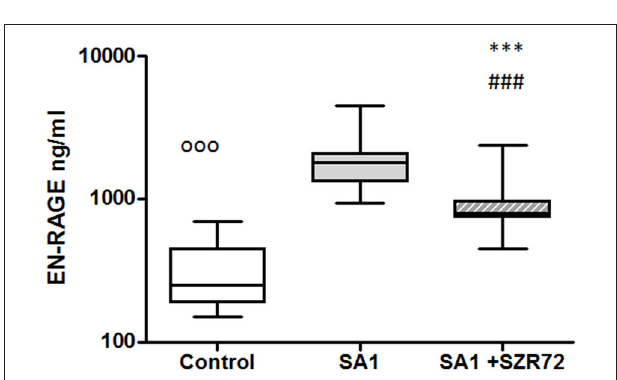
FIGURE 8 | The effect of KYNA analog, SZR72 on S100A12 (EN-RAGE) production in human whole blood cells of normal blood donors stimulated by heat-inactivated Staphylococcus aureus. Ethylenediaminetetraacetic acid (EDTA)-anticoagulated blood samples 1–1ml from each of 20 donors were incubated with SZR72 at a concentration of 500 µ m for 30min prior to the addition of heat-inactivated Staphylococcus aureus (10 7 /ml). The concentrations of EN-RAGE in the plasma were determined after an 18 h-incubation period. The data are depicted as box and whiskers plots, where the lines inside the boxes denote medians, and the boxes mark the interval between 25 and 75 percentiles, and the whiskers, the maximum and minimum. Significance was determined by the Friedman’s test. Control vs. SA1, ooo p < 0.001; control vs. SA1 + SZR 72, ### p < 0.001; SA1 vs. SA1 + SZR 72, *** p < 0.001, according to the Dunn’s